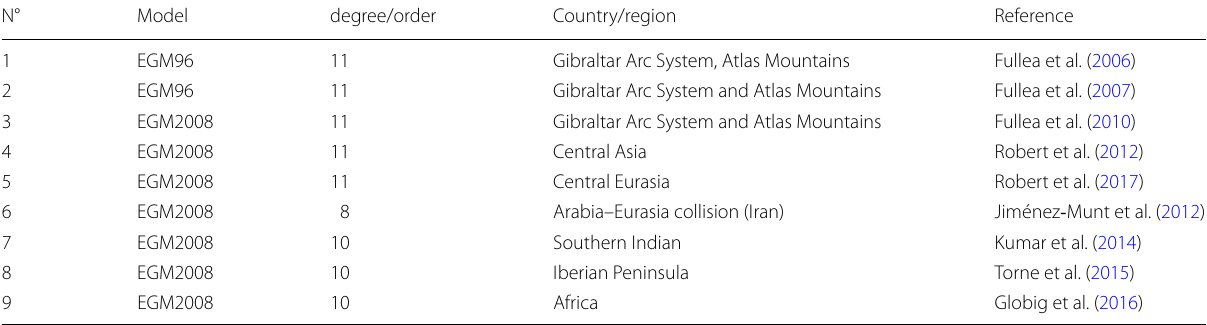
Table 1 Statistics of the low d/o spherical harmonics used for filtering geoid heights